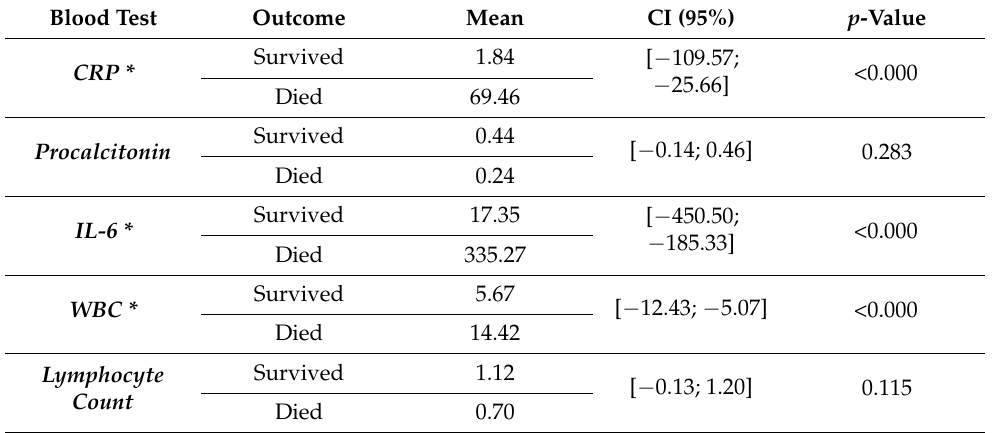
Table 4. Statistical analysis comparing the surviving patients and the